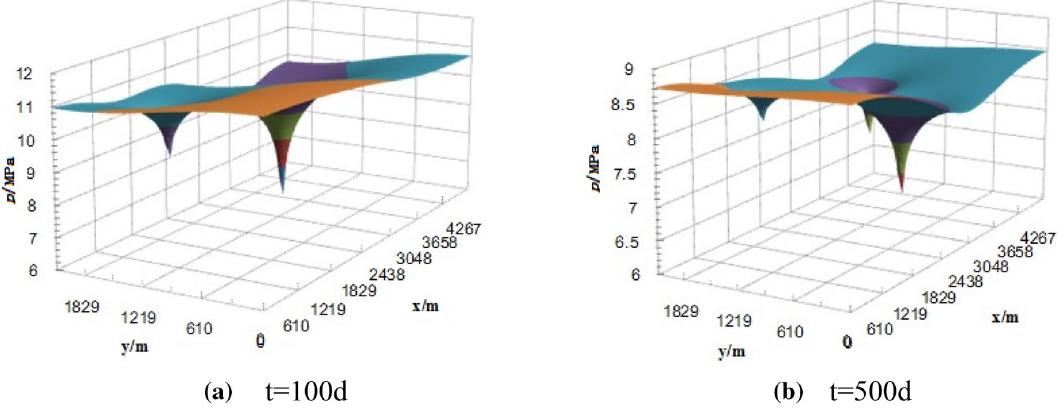
Fig. 4 The pressure distribution at 100 and 500